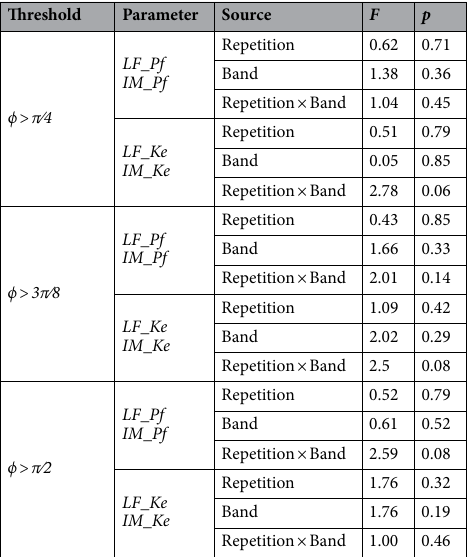
Table 2. Repeated measures ANOVAs in control group ( N = 3) for different thresholds and frequency band